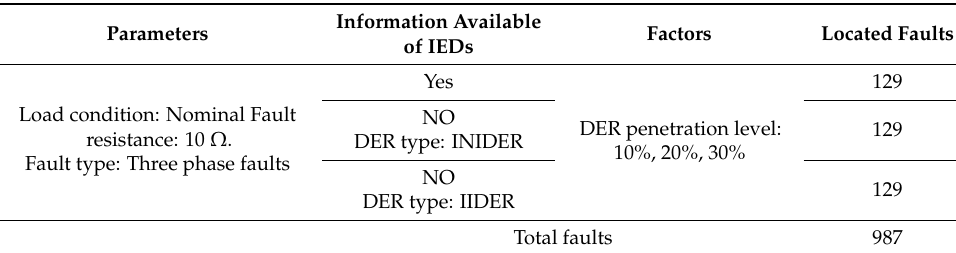
Table 3. Simulation data for scenario